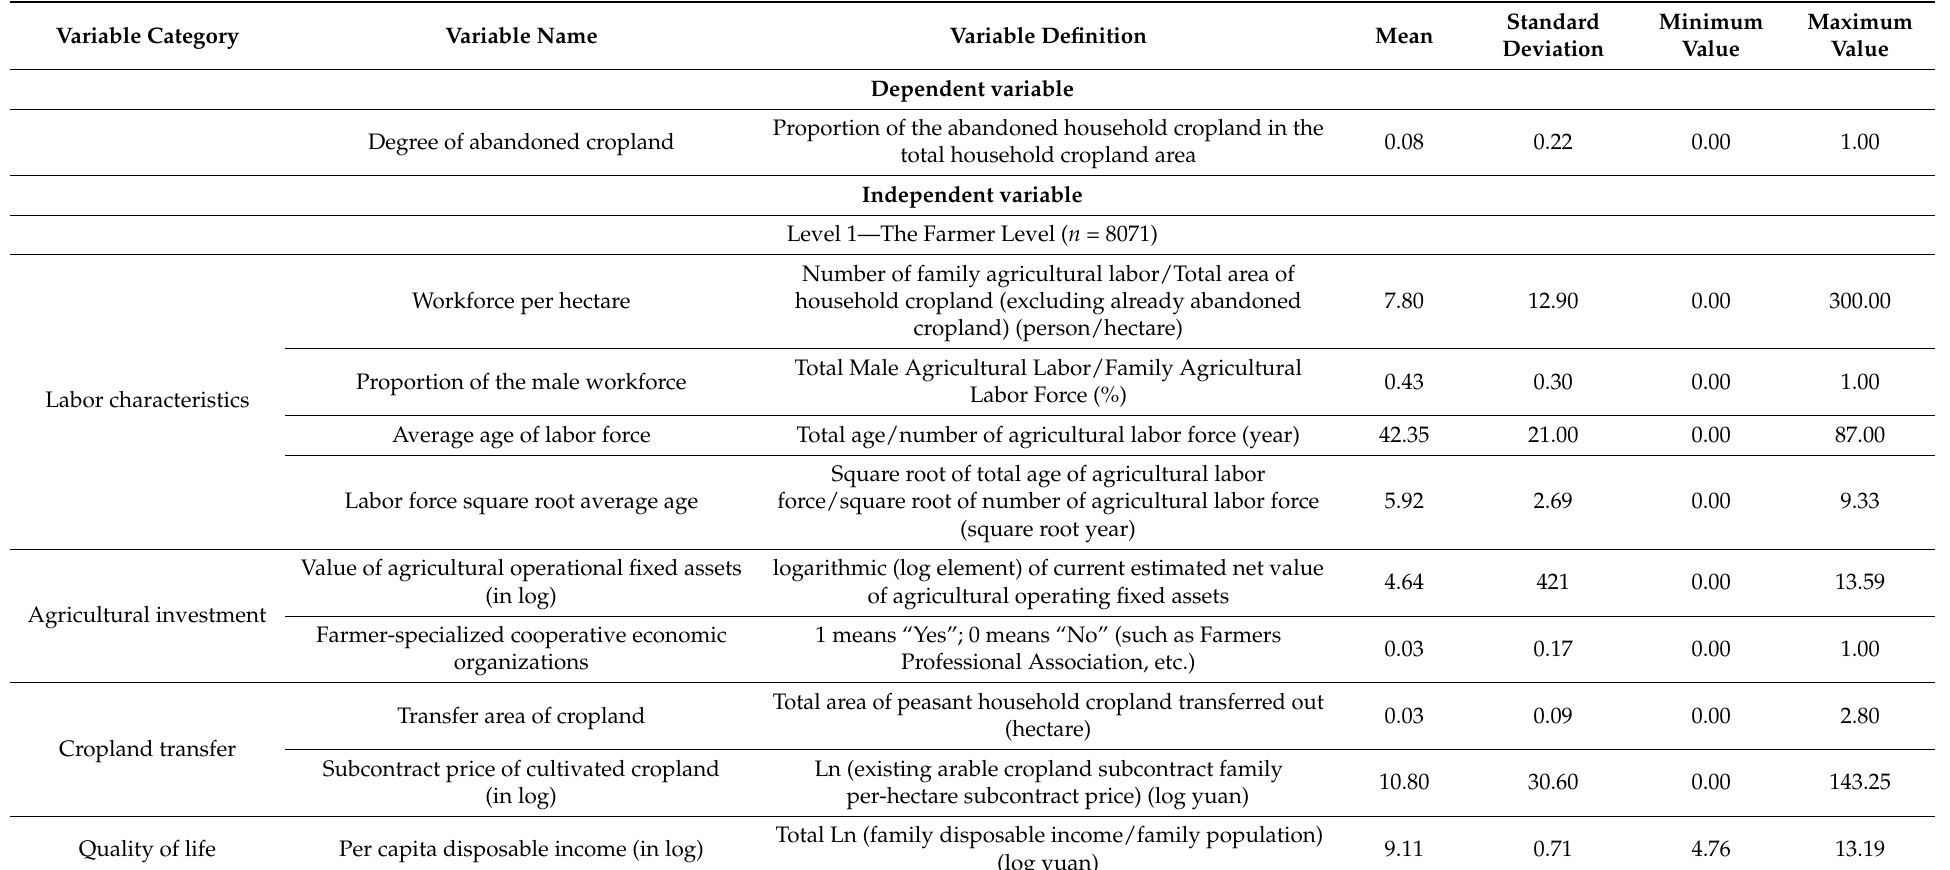
Table 1. Descriptive statistics of multi-level model